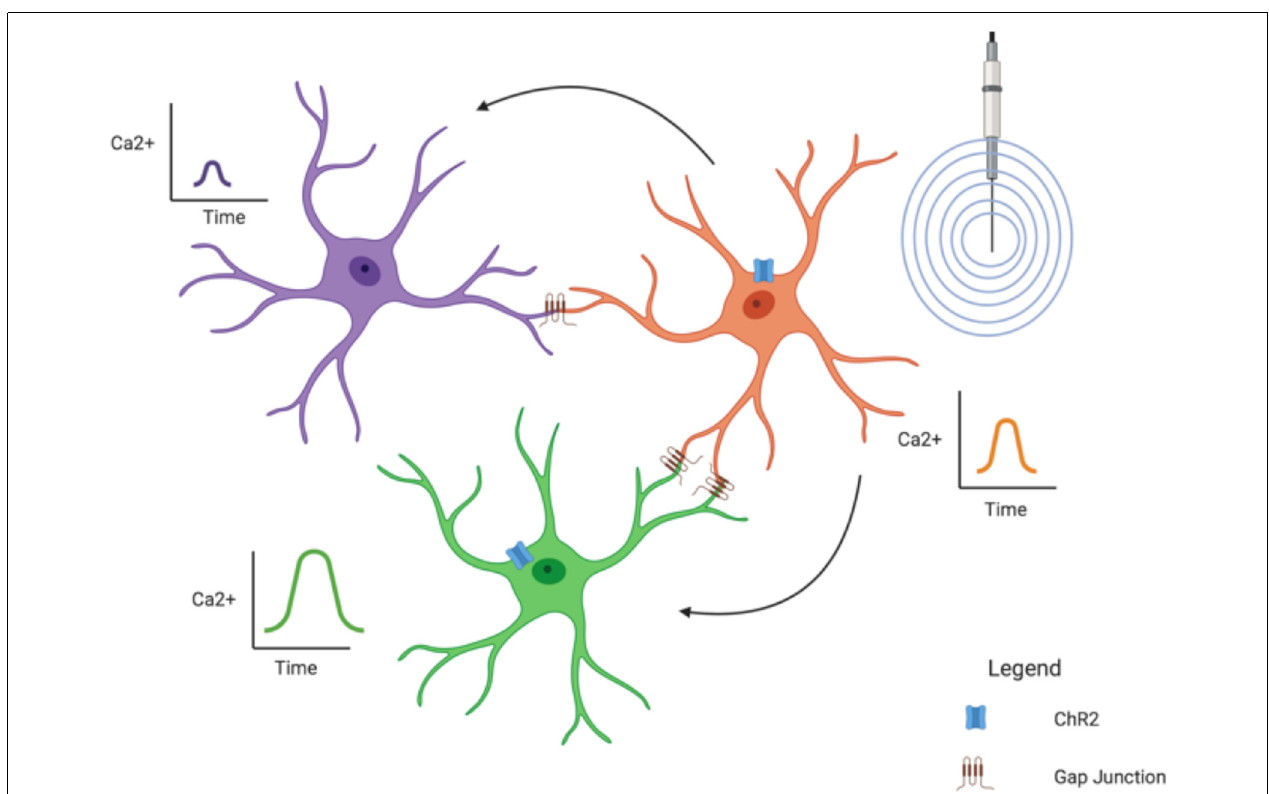
FIGURE 3 | The glial syncytium may impact the physiological effects of optogenetics and DREADD technologies (optogenetics illustrated above). The connection of astrocytes via gap junction proteins might produce a “double stimulation” or “spillover” effect. In the diagram above, only a portion of the astrocytes (orange and green) express the opsin of interest. The green astrocyte is first stimulated following the introduction of light into the system, and then again when a neighboring astrocyte (orange) is also stimulated, generating a larger than anticipated response. In the case of “spillover,” astrocytes that do not express the opsin or DREADD in use nonetheless become “stimulated” from the activation of its neighboring astrocytes. In the image above, the purple astrocyte still exhibits a response following light stimulation despite the lack of ChR2 expression. The “stimulation” arises from the influence of the connected astrocyte (orange) that is stimulated via its ChR2 ion